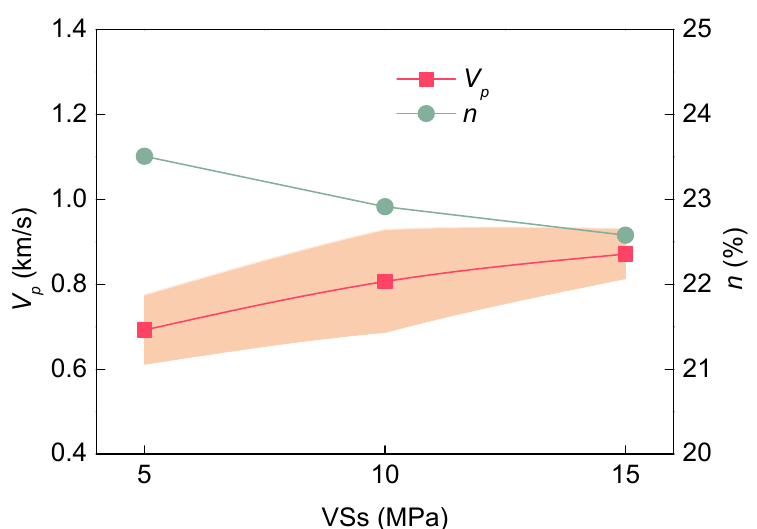
Figure 3. Relationships between P-wave velocity ( ) and porosity ( ) with vertical stress (VSs).